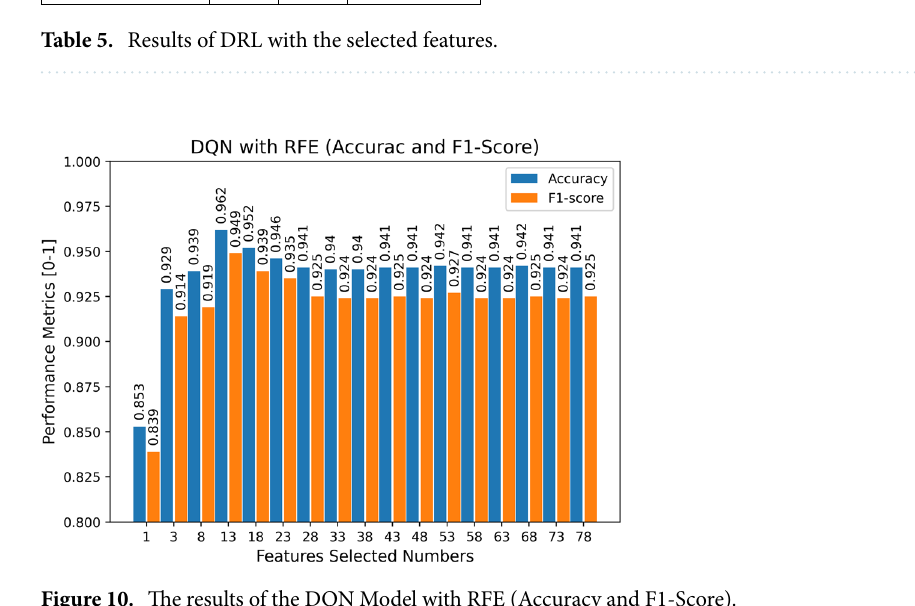
Figure 10. The results of the DQN Model with RFE (Accuracy and